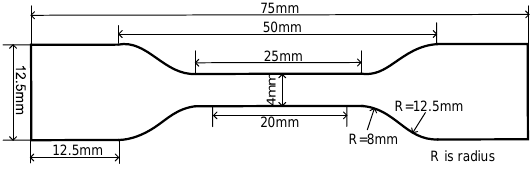
Figure 2. Schematic diagram of XLPE dumbbell sample for the tensile test.